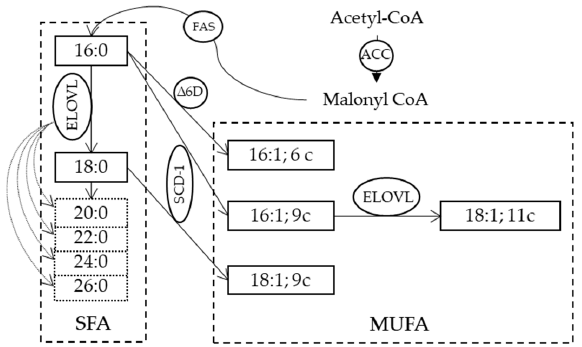
Figure 3. The de novo synthesis of saturated fatty acids (SFA) starting from acetyl CoA and the transformation to monounsaturated fatty acids (MUFA) by two desaturase enzymes. Structures of some of these fatty acids are shown in Figure 1. ACC: acetyl CoA: carboxylase; FAS: fatty acid synthase; ELOVL: elongase enzyme; Δ 6D: delta-6 desaturase ( Δ 6); SCD-1: stearoyl CoA desaturase. Cancer cells modify lipid metabolism in order to respond to environmental modifications.